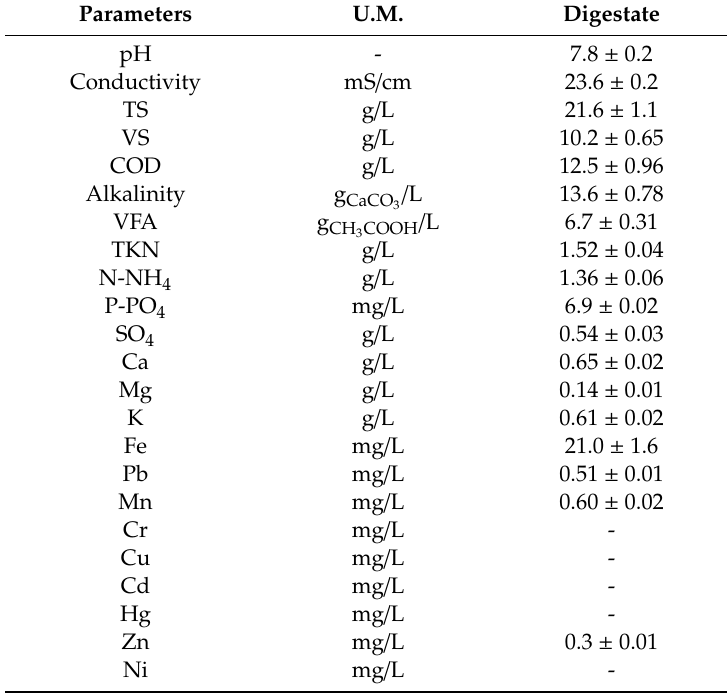
Table 4. Characteristics of digestate produced when the reactor worked at OLR = 24.5 kg COD / m 3 d and HRT = 2.7